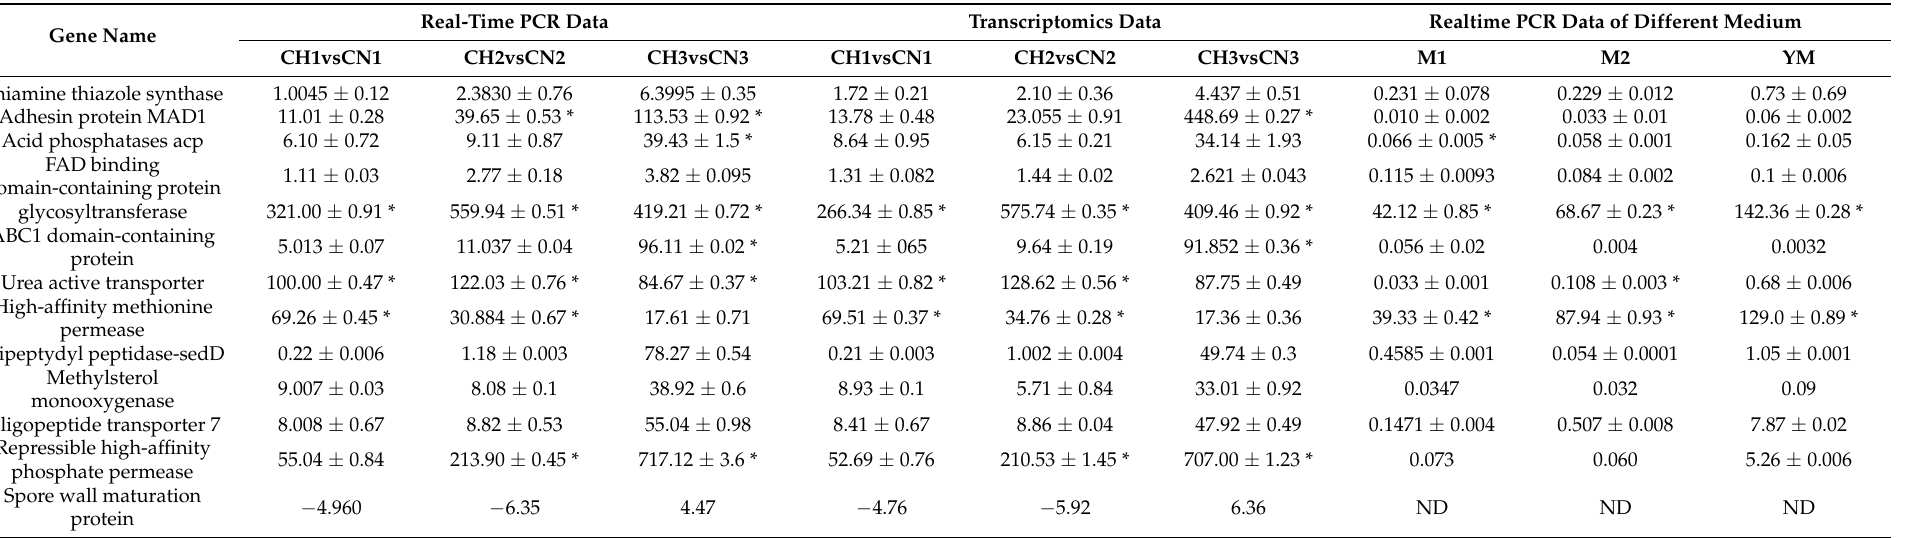
Table 2. Comparison of 13 selected different expression genes detected by qRT-PCR and